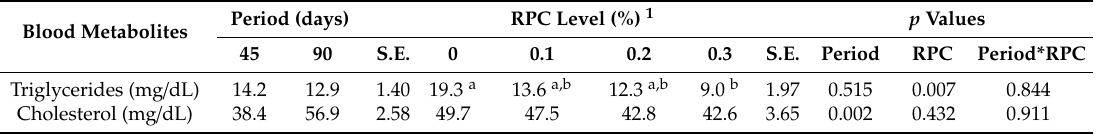
Table 5. Blood serum triglyceride and cholesterol concentrations of lambs fed diets containing various RPC